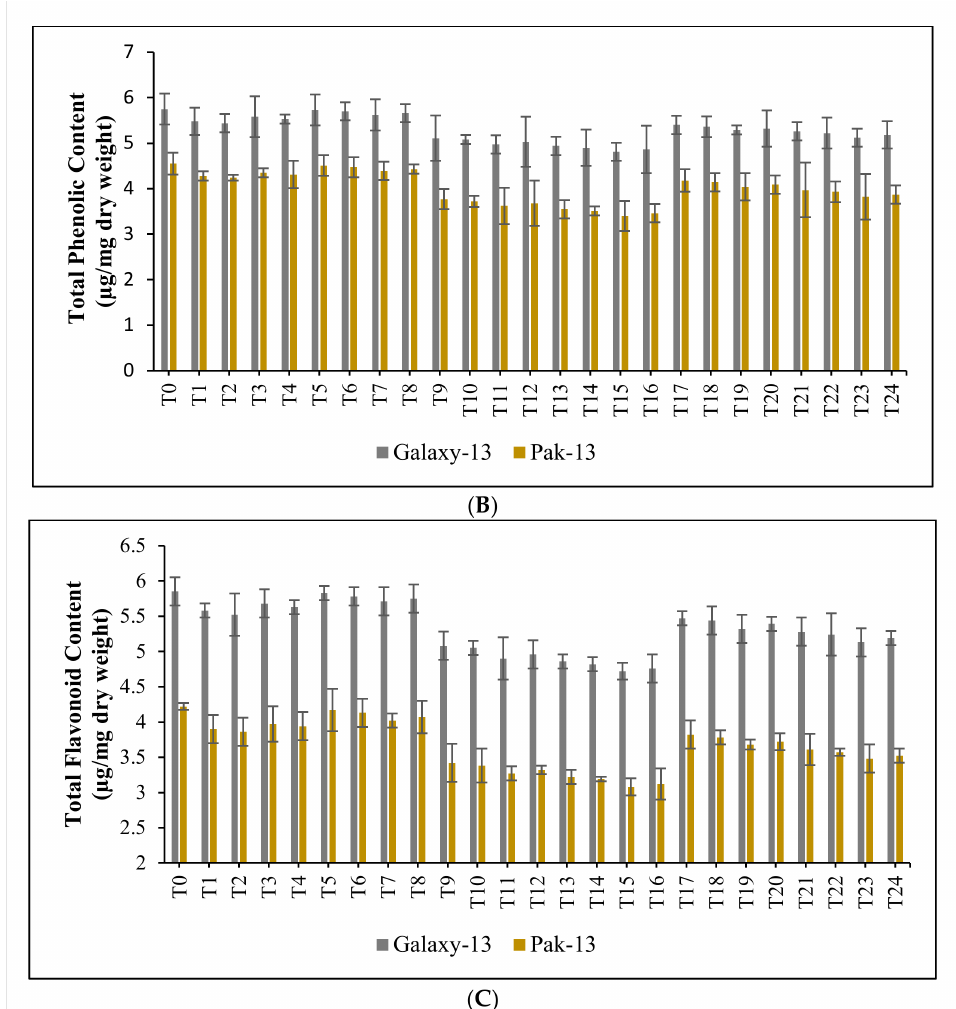
Figure 5. ( A ): effect of phytogenically synthesized bimetallic Ag/ZnO nanomaterials and nitrogen- based fertilizers on malondialdehyde content of wheat varieties; ( B ): effect of phytogenically syn- thesized bimetallic Ag/ZnO nanomaterials and nitrogen-based fertilizers on total phenolic content of wheat varieties; ( C ): effect of phytogenically synthesized bimetallic Ag/ZnO nanomaterials and nitrogen-based fertilizers on total flavonoid content of wheat